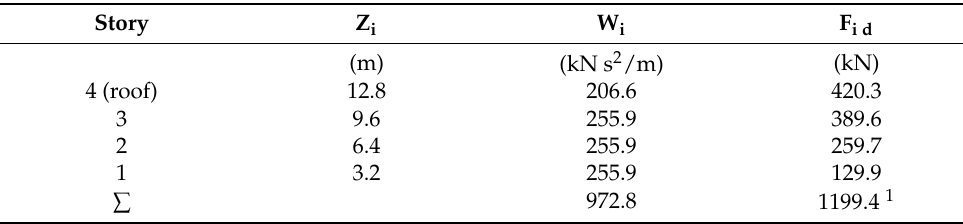
Table 2. Seismic force for each floor under non-collapse (NC) limit state loading.